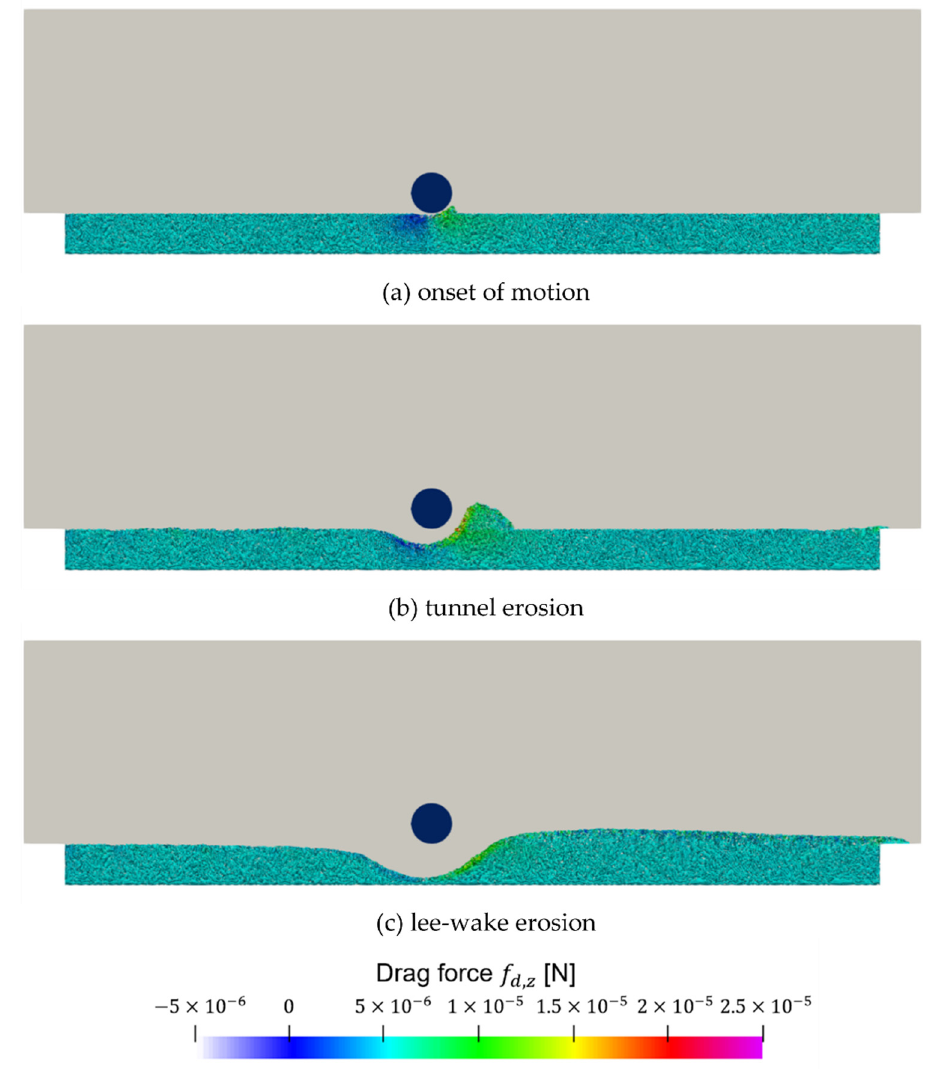
Figure 15. z-directional particle drag force ( f d , z ).